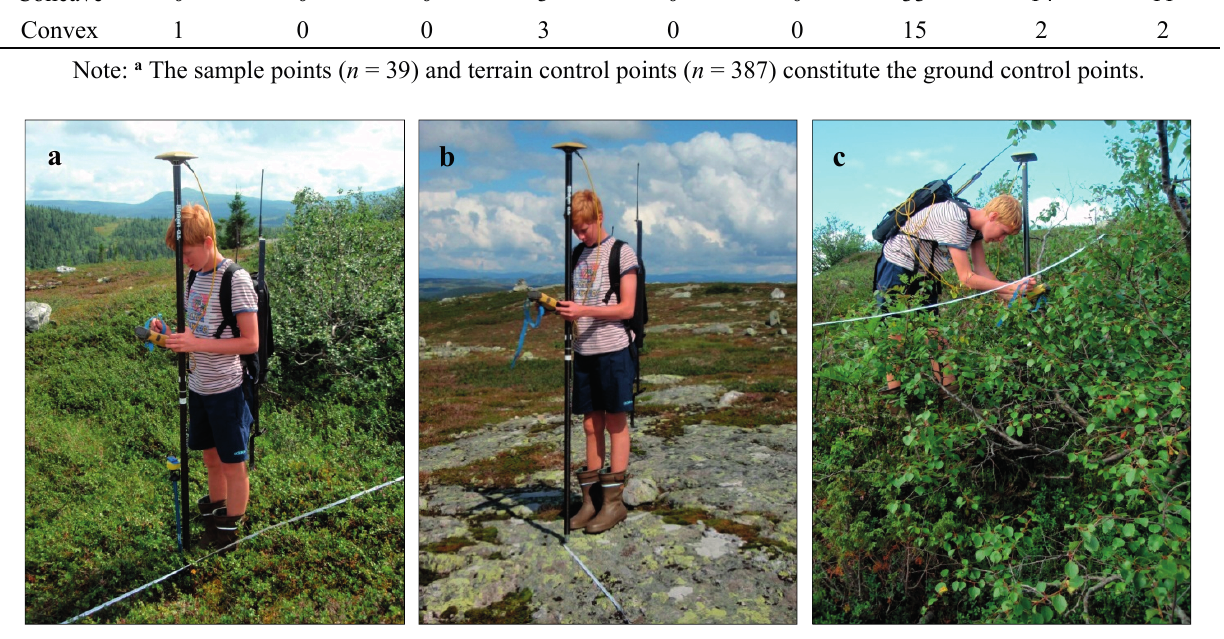
Figure 2. Examples of three ground control points with different characteristics. ( a ) A flat location with green vegetation surface and vegetation height 10–20 cm; ( b ) A flat location with rock/bare surface and vegetation height < 10 cm; ( c ) A concave location with green vegetation surface and vegetation height > 20